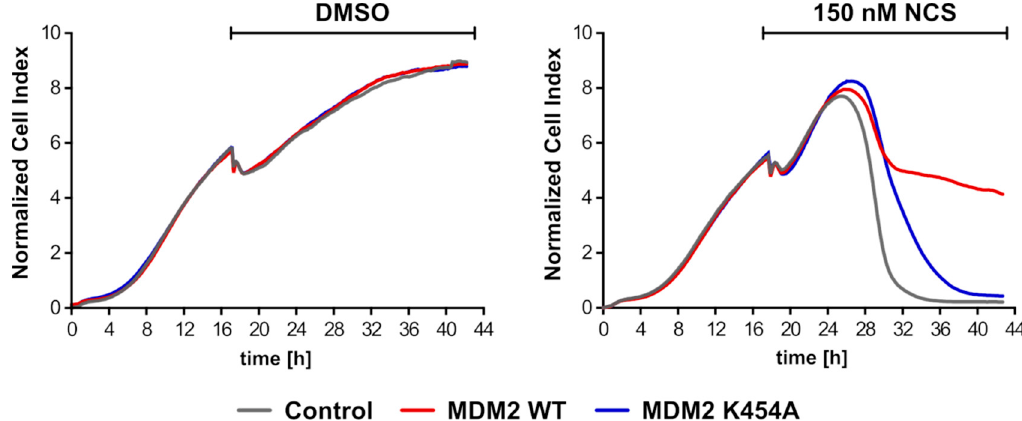
Figure 8. Acquisition of chemoresistant phenotype by MDM2-overexpressing H1299 cells. Real-time cell proliferation monitoring was performed with the RTCA DP xCelligence system; cells were transfected with MDM2 WT, MDM2 K454A or GFP plasmid (Control) and treated with 150 nM NCS or DMSO as the treatment control.